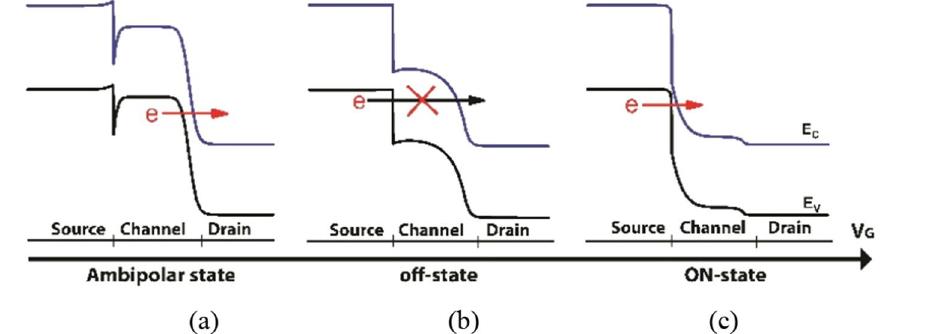
Figure 2. Band diagram of COCC structure: ( a ) ambipolar-state, ( b ) off-state, ( c ) ON-state.